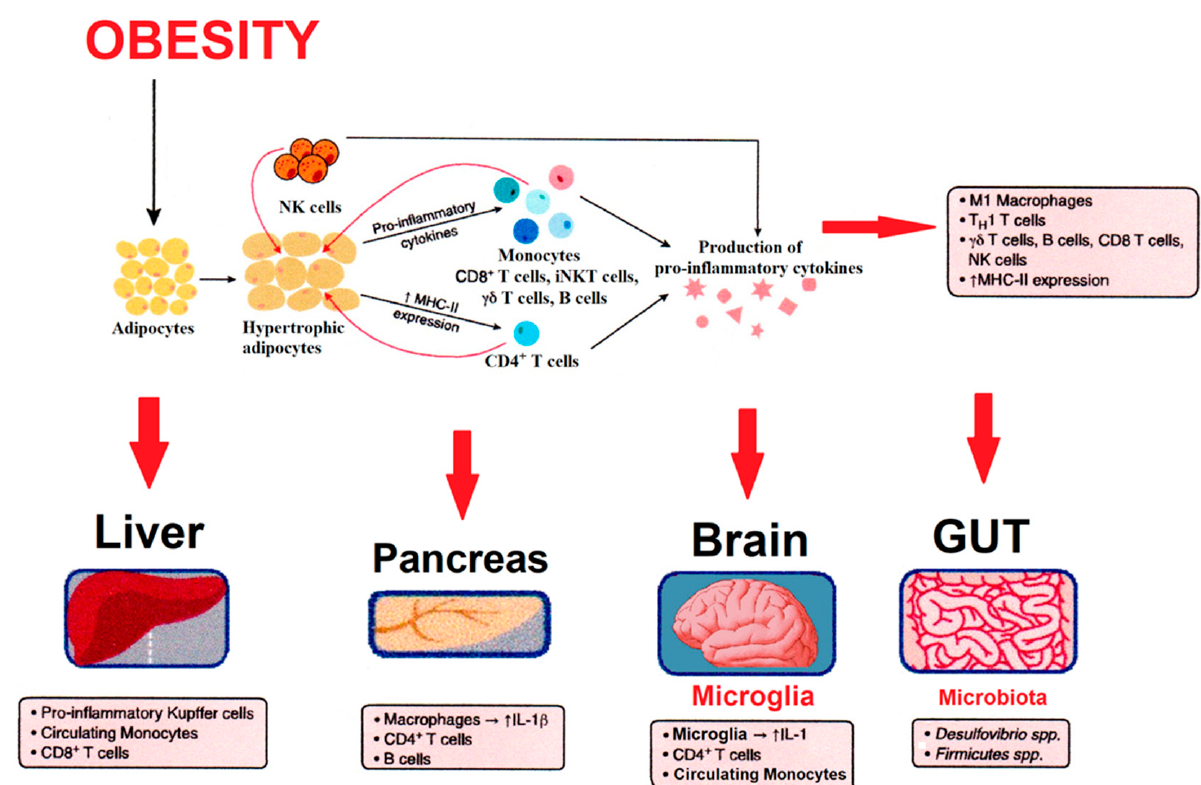
Figure 1. Scheme of peripheral inflammation connectivity involving obesity-induced insulin resistance in the adipose tissue in obesity and type 2 diabetes mellitus.